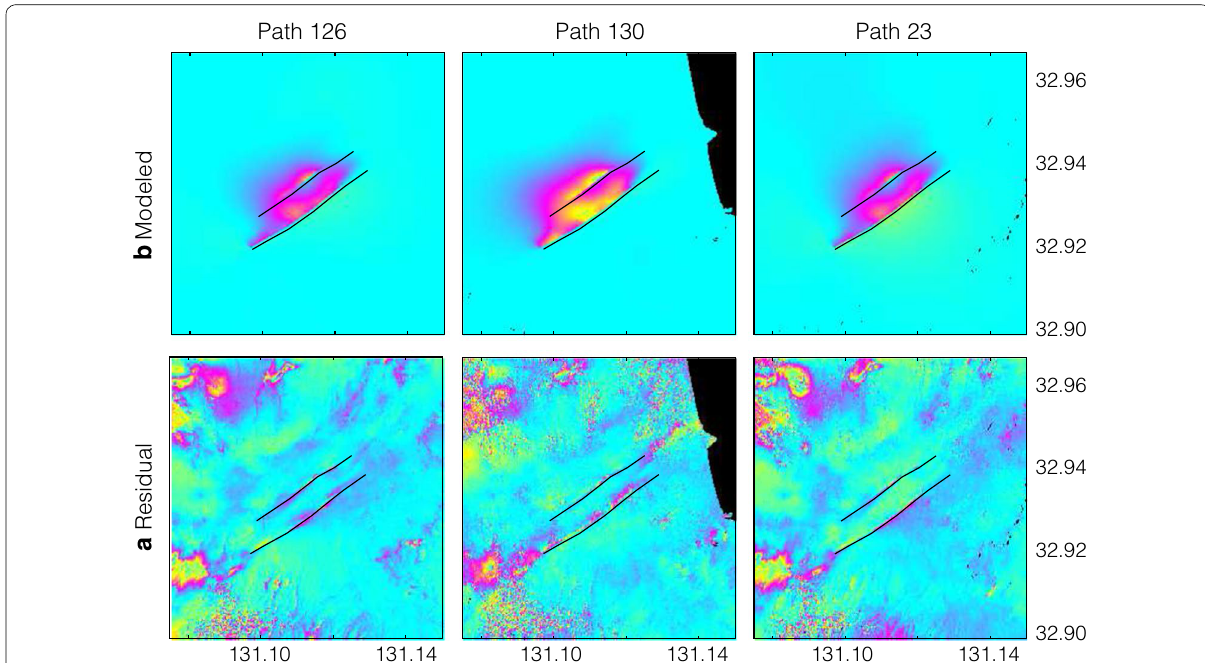
Fig. 10 a Modeled data corresponding to the maximum likelihood fault slip model and b residual data, calculated by subtracting ( a ) from Fig. 6c, for the three data sets. The data are shown rewrapped with the same colorscale as Fig. 6 for better